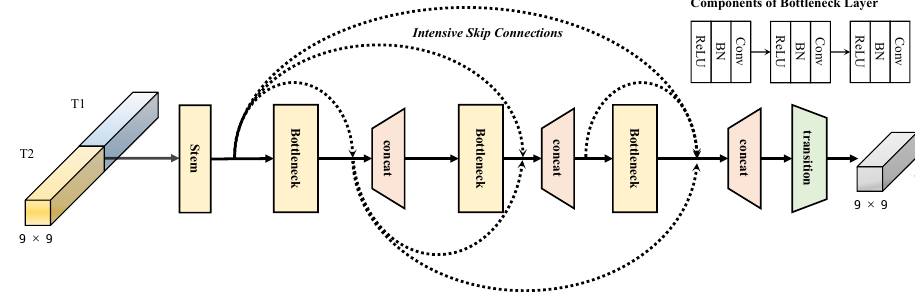
Figure 4. The structure of the proposed intensive connected block.